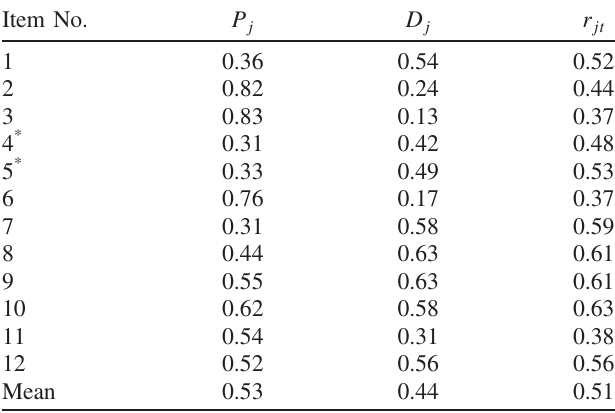
TABLE IV. Item statistics: Item difficulty index P j , item discriminatory index D j , and item-test correlation coefficient r j . The items with an * indicate items which had jt for each item several true or false subitems in which a field-line representation needed to be assigned to a given vector-field